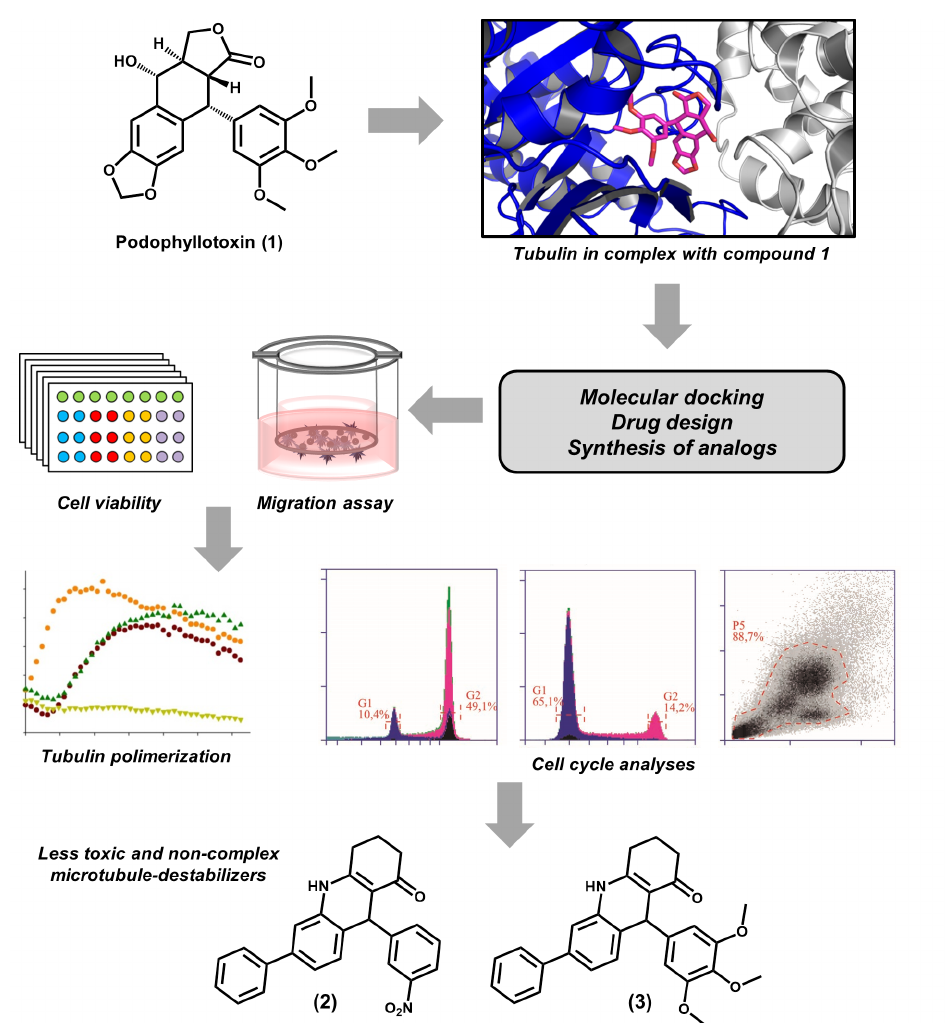
Figure 2 - Medicinal chemistry approaches used in the identification of novel microtubule destabilizing agents. By using podophyllotoxin as the reference compound, the integration of molecular modeling, organic synthesis and target-based and phenotypic methods led to discovery of a novel class of non- complex tubulin polymerization